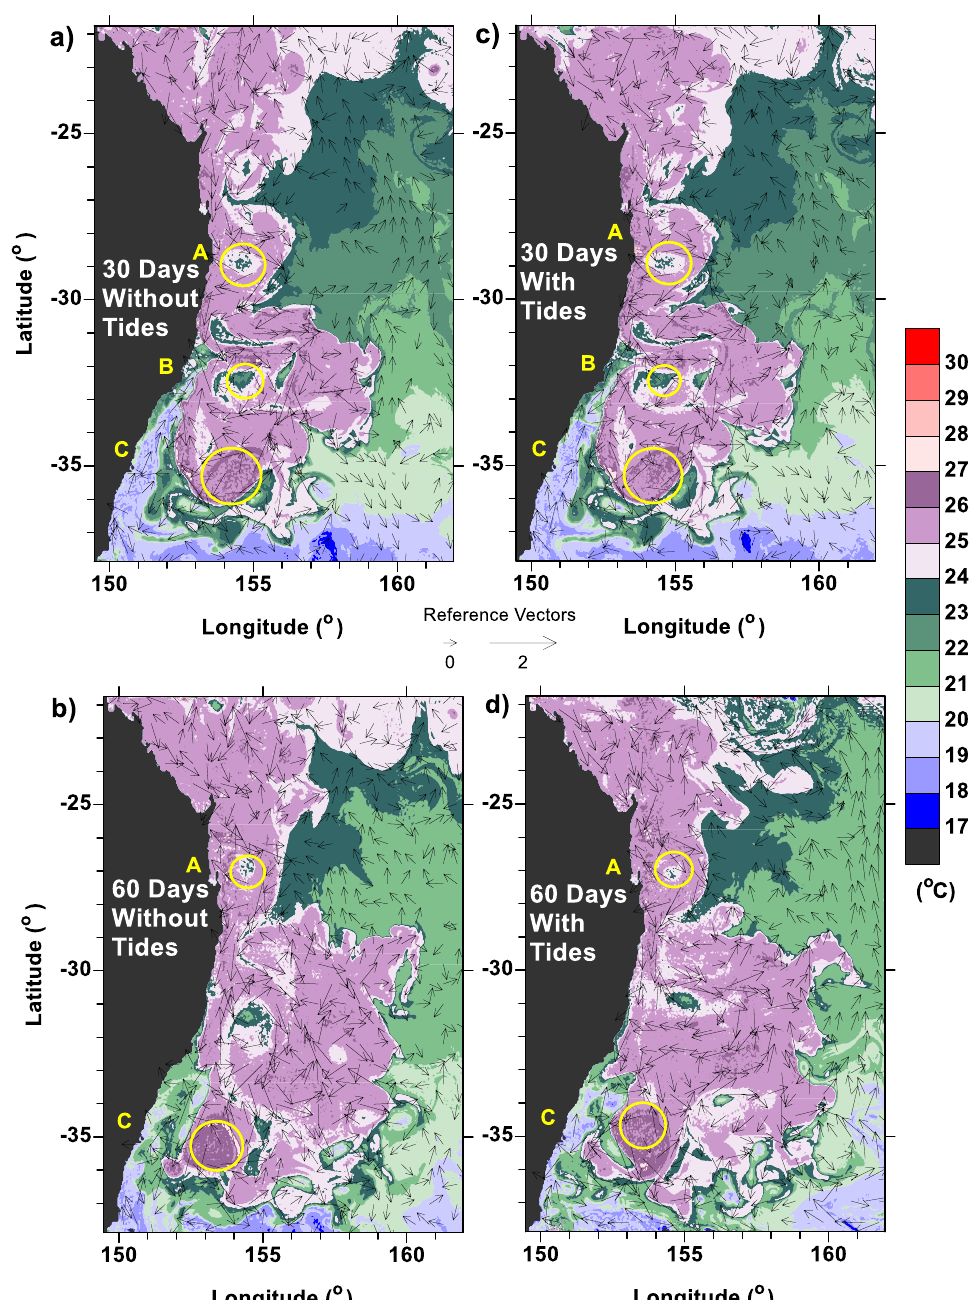
Fig. 4 Surface temperatures and velocity vectors at 30 days from simulations a without and c with tides and at 60 days b without and d with tides. The three eddies discussed in the text are indicated with a yellow circle for their edge and labeled A , B , and C in each